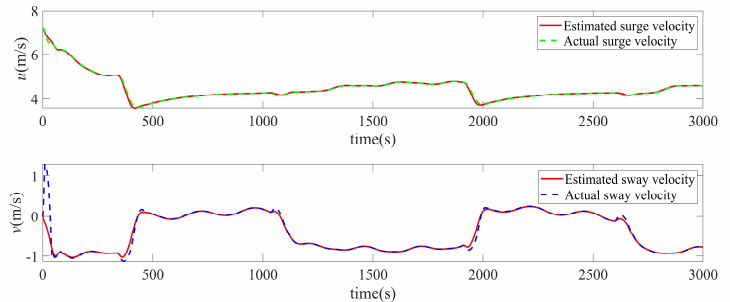
Figure 8. Comparison of estimated velocity and actual velocity.